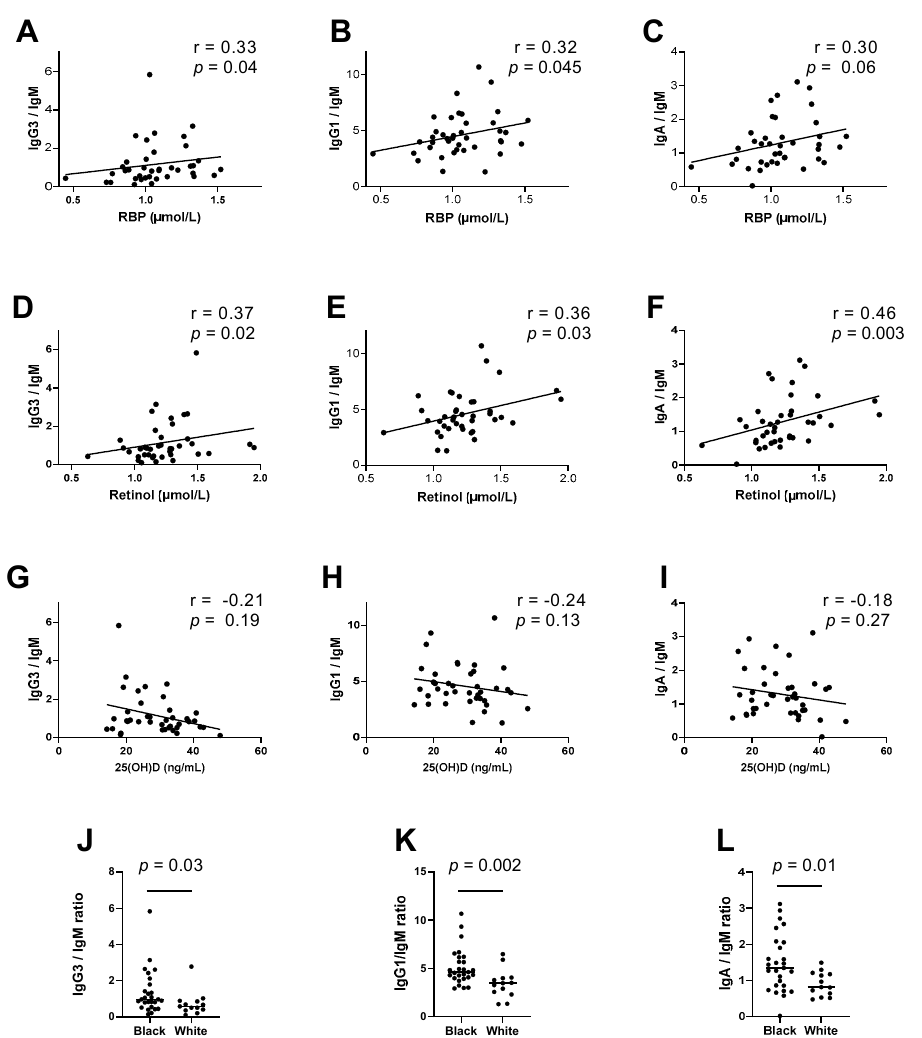
Figure 4. Vitamin levels correlate with serum immunoglobulin isotype patterns. ( A – I ) RBP and retinol, but not 25(OH)D, correlate positively with isotype ratios, indicative of immunoglobulin class switch from IgM to non-IgM isotypes. Each symbol represents a different participant. A simple linear regression line is plotted. Spearman correlation test results are shown. ( J – L ) Black and white children differed significantly in isotype ratios. Medians and results from Mann–Whitney tests are shown.